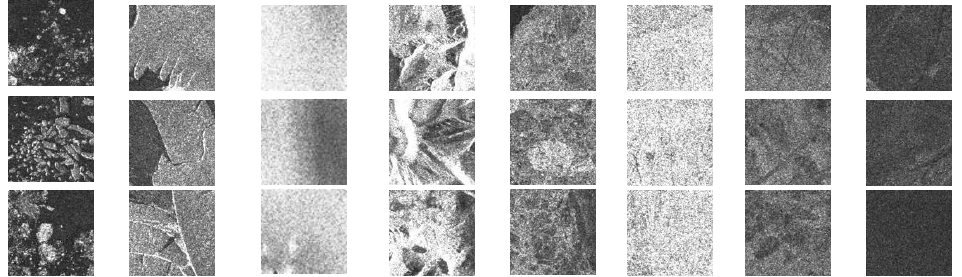
Figure 3. Examples of three classified patches per column: The semantic meaning of each category (from left to right) is: Floating Ice , Icebergs , Glaciers , Mountains , Old Ice , First-Year Ice , Young Ice , and Water Bodies .